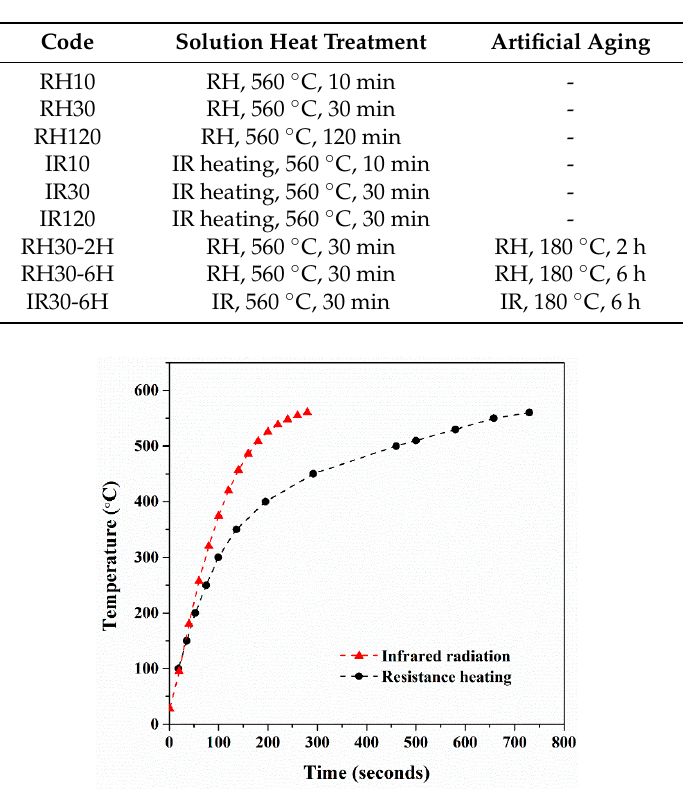
Table 2. Experimental parameters and specimen codes.